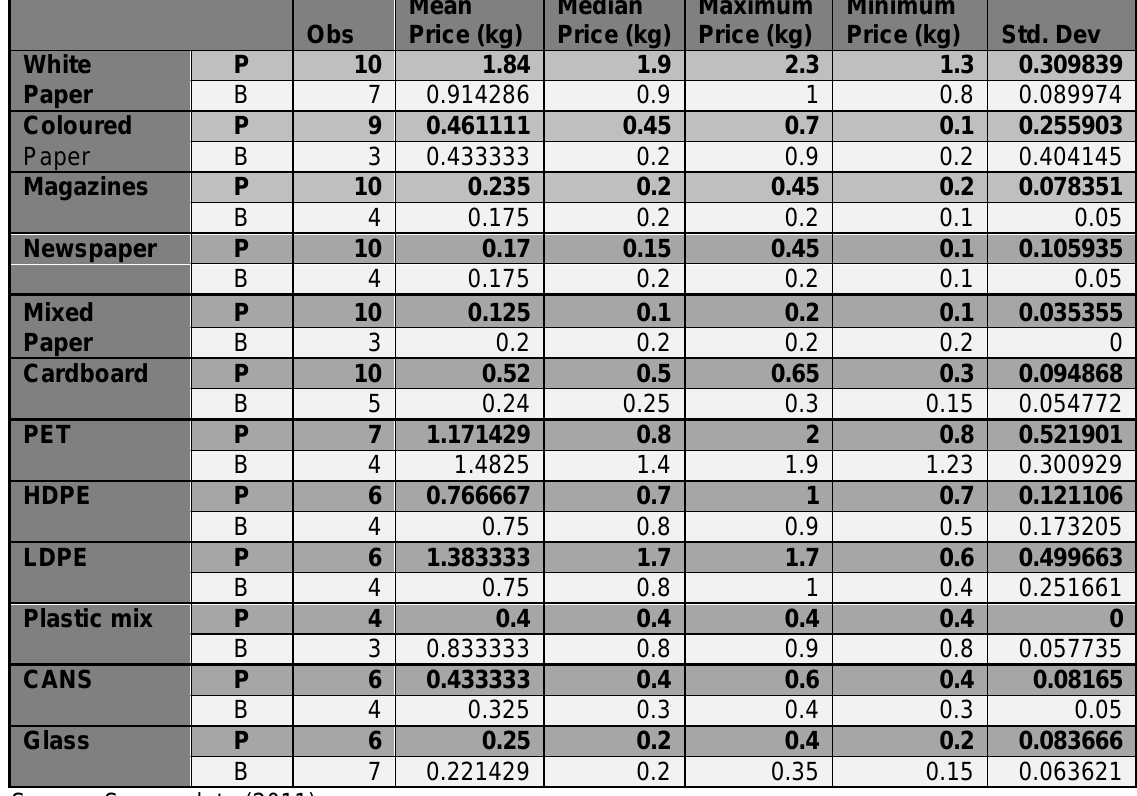
Table 3: Mean, maximum and minimum prices and standard deviation of the different recyclable waste products (per kg), in Pretoria (P) and Bloemfontein (B). Mean Median Maximum Minimum Obs Price (kg) Price (kg) Price (kg) Price (kg) Std.